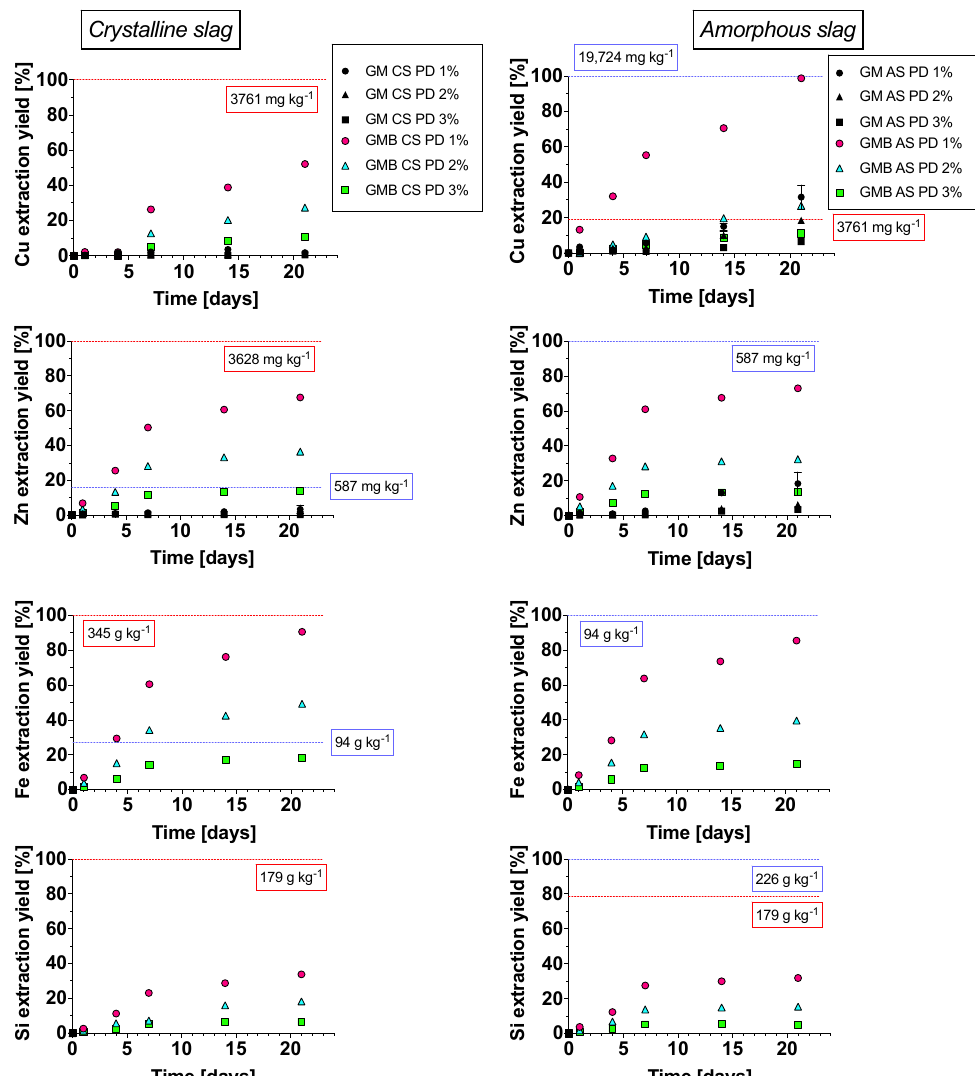
Figure 6. (Bio)extraction of metals from crystalline and amorphous slags treated with growth medium and growth medium with bacteria Acidithiobacillus thioxidans . Values indicated in: (i) red-colored line and rectangle present bulk metal content in CS, (ii) blue-colored line and rectangle indicate bulk metal content in AS.